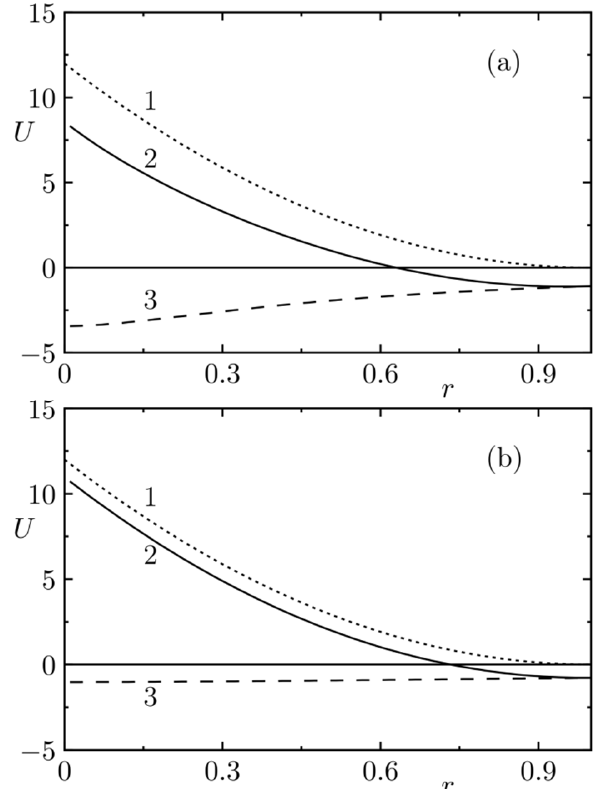
Figure 4. The interaction between oppositely charged beads of the same type, i.e., the sum of the DPD repulsive potential with a ij = 25 and the smeared electrostatic potential of two oppositely charged clouds (total charges of clouds + e and − e ) for λ = 0.2 ( a ) and λ = 0.67 ( b ). The full lines (2) represent the sum of the electrostatic (3) and repulsive potentials (1). Reproduced from Phys. Chem. Chem. Phys. 2016 , 18 , 16127 https://pubs.rsc.org/en/content/articlelanding/2016/cp/c6cp00341a, accessed on 15 December 2021 (supporting information) with permission from the PCCP Owner Societies.